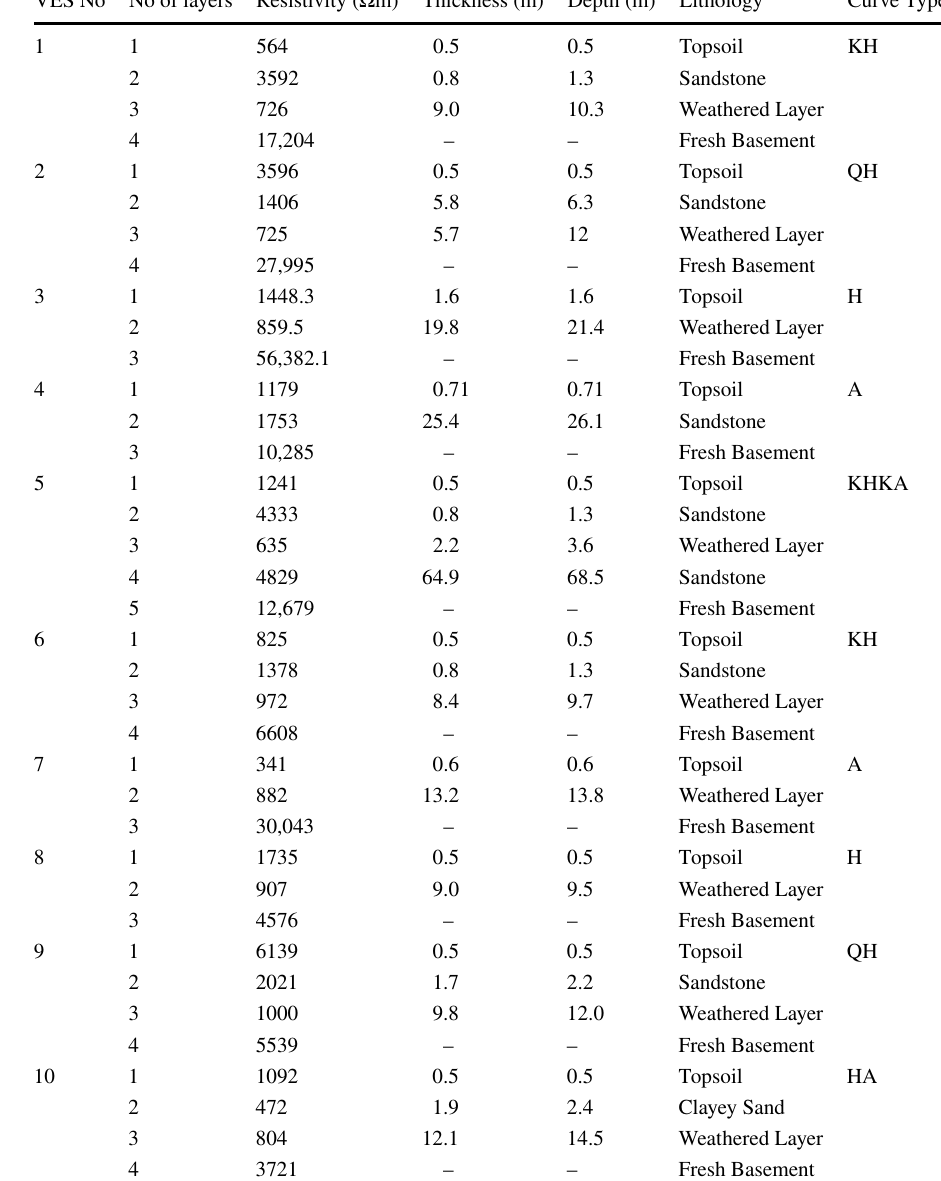
Table 1 Summary of the VES geoelectric parameters